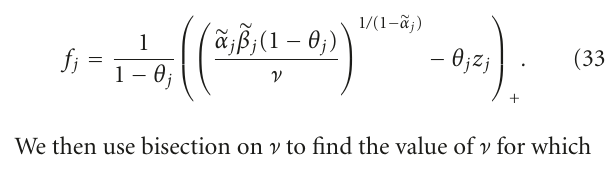
Figure 3: Average utility versus average power: heavily smoothed flow (top, dashed), and lightly smoothed flow (bottom).